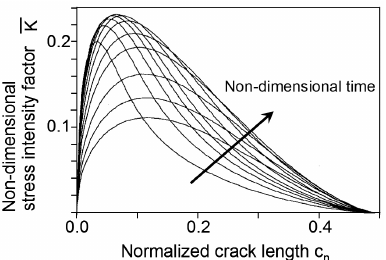
Figure 2. Non-dimensional stress intensity factor as a function of the normalized crack length. The arrow indicates the direction of the non-dimensional time. This graph was adapted from the work of Cotterell et al. 1